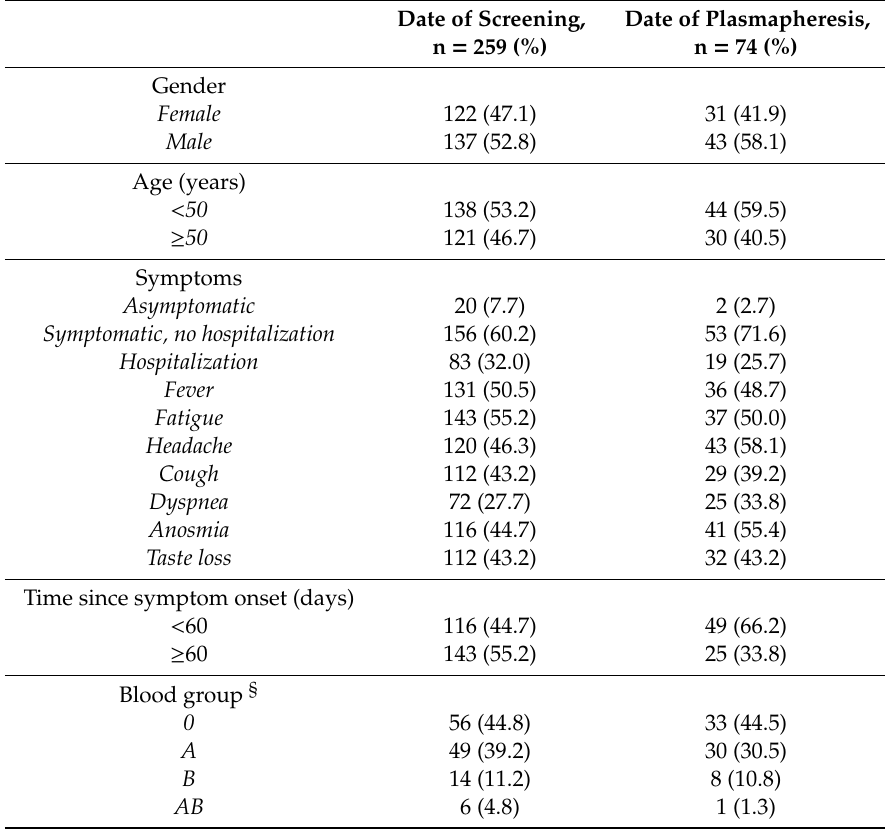
Table 1. Characteristics of donors on the day of screening and on the day of